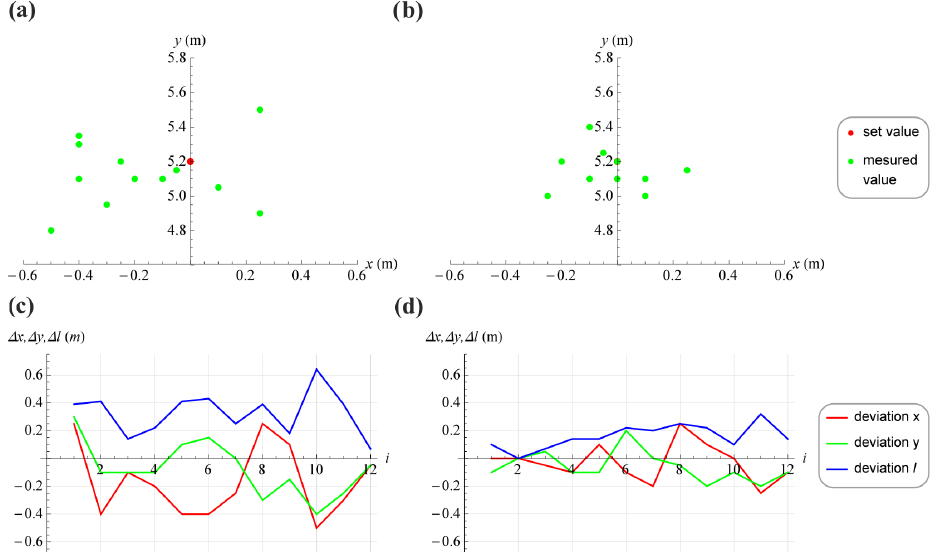
Figure 8. Accuracy measurement of the first control point. ( a ) Green points represent measured positions when the robot was standing still. The red point is an aim point. In this experiment, the robot had the vision system turned off. ( b ) The robot had the vision system turned on. ( c ) Deviations from the aim point in x and y , the vision system was off. ( d ) Deviations from the point where vision system was